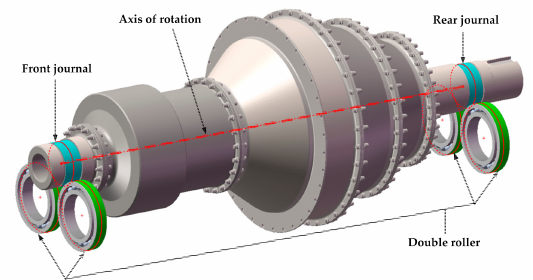
Figure 4. A simplified structure of the supporting form in the dynamic balancing